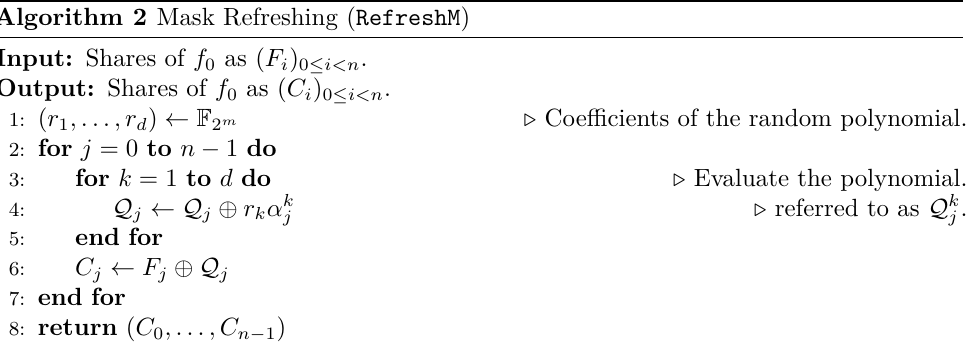
Algorithm 2 Mask Refreshing ( RefreshM